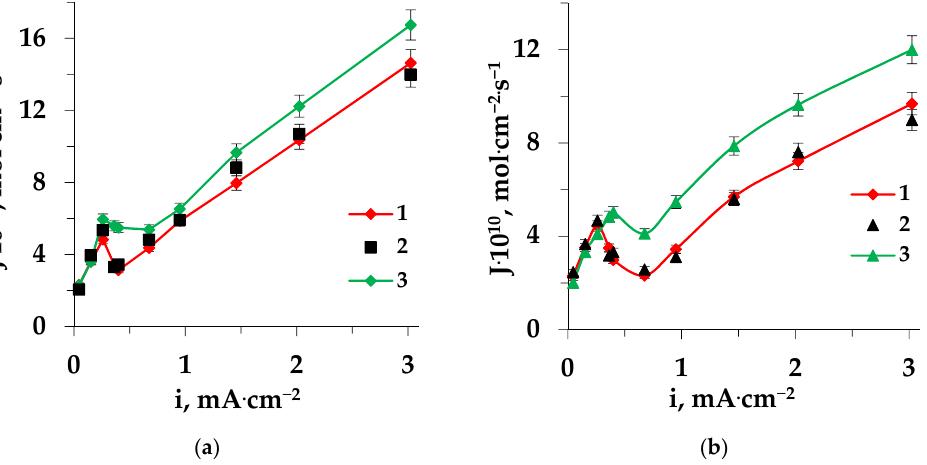
Figure 8. Dependences of amino acid fluxes through the MK-40 ( a ) and MA-41 ( b ) membranes on the current density during electrodialysis of Pro + NaCl solution: 1—pristine membrane, 2—regenerated membrane, and 3—fouled membrane. With prolonged use of the membranes, a decrease in the influence of the barrier ef- fect was observed, apparently due to the accumulation of amino acids in the membrane phase and on the surface, leading to an increase of the impact of electroconvection and an increase in the effect of facilitated transport.